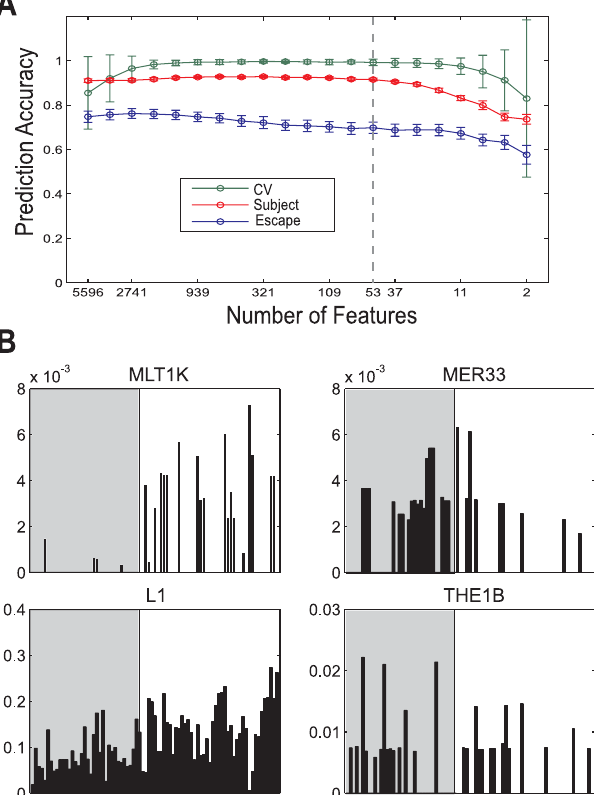
Figure 3. Recursive Feature Reduction and Distributions of Consistent Features across the XAR Nonborder Genes (A) The mean prediction accuracy and standard deviations ( y -axis) for 100 recursive feature reduction iterations are shown for the indicated number of genes ( x -axis). Green represents the CV rate using randomly selected two-thirds of the XAR nonborder genes for each set of features. The prediction rates for escaping genes (blue) and subject genes (red) in the remaining one-third are also shown. Both escape and subject prediction rates begin declining when the feature set is reduced to fewer than 53 features. (B) The content of each feature ( y -axis) in specific windows around the transcription start sites for all 82 XAR nonborder genes ( x -axis) is represented as a histogram. The first 36 genes on the x -axis escape X inactivation (shaded area), and the remaining 46 are subject to X inactivation. Features found to be consistently chosen during recursive feature reduction for the creation of accurate classifiers are L1 100 kb downstream, MLT1K 100 kb upstream, and MER33 100 kb upstream. For comparison, THE1B 50 kb upstream, a randomly distributed feature, is also shown. DOI: